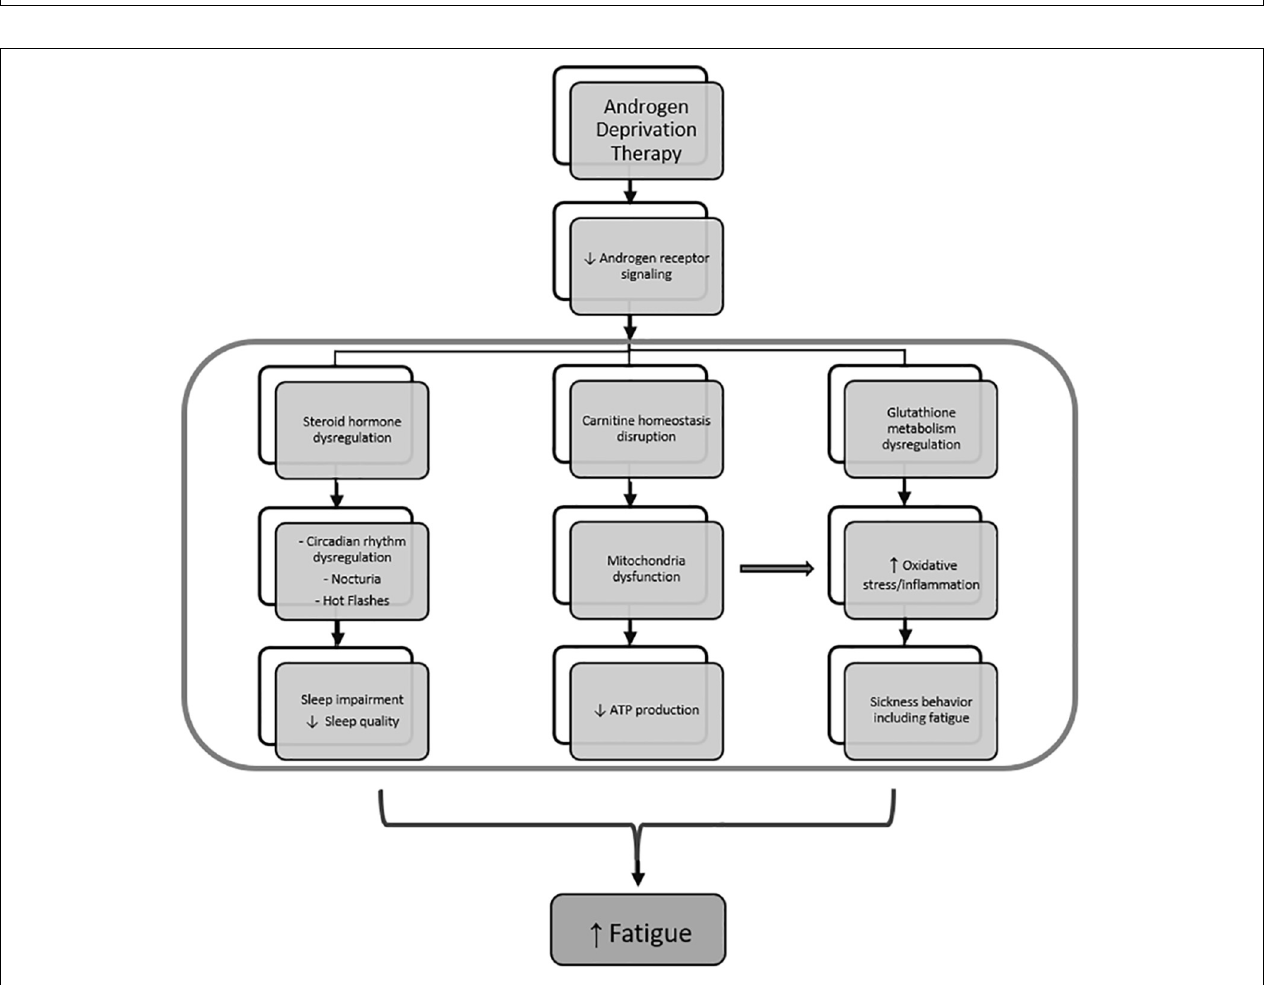
FIGURE 7 | Mechanism of fatigue related to androgen deprivation therapy. Androgen deprivation therapy, which inhibits androgen receptor signaling, results in steroid hormone metabolism dysregulation and leads to sleep impairment by affecting circadian rhythm regulation, nocturia, and hot flashes. At the same time, androgen deprivation also results in dysregulated carnitine homeostasis and glutathione metabolism, leading to mitochondrial dysfunction and oxidative stress, respectively. Mitochondrial dysfunction further increase oxidative stress and contributes to inflammation-induced sickness behavior that includes fatigue.